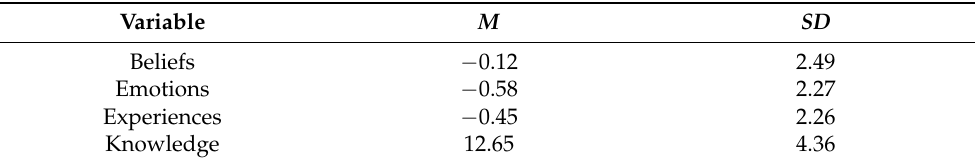
Table 2. Descriptive Statistics for Main Correlates.